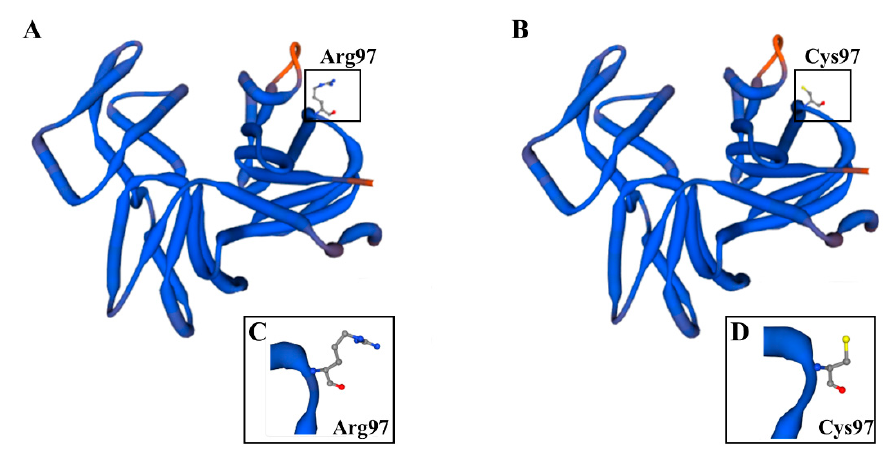
Figure 1. Model of the natural ACTIN2 protein structure and its mutated version in der1–3 mutant. ( A , B ) SWISS model of the tertiary protein structure of ACTIN2 based on the wild-type gene sequence ( A ) or on the gene sequence altered by single-point mutation in the der1–3 mutant ( B ). Topological location of arginine in the position 97 of the natural ACTIN2 ( A ) and substituted cysteine in the position 97 of the mutated ACTIN2 ( B ) of the der1–3 mutant are showed in boxes. ( C , D ) Detailed structure of spatial arrangements of Arg97 ( C ) and Cys97 ( D ) from the boxed area in ( A , B ), respectively. 3D rotational models of protein structures are presented in Videos S1 and S2. Models of protein structures were produced in the application SWISS-MODEL (Biozentrum, University of Basel, Switzerland).